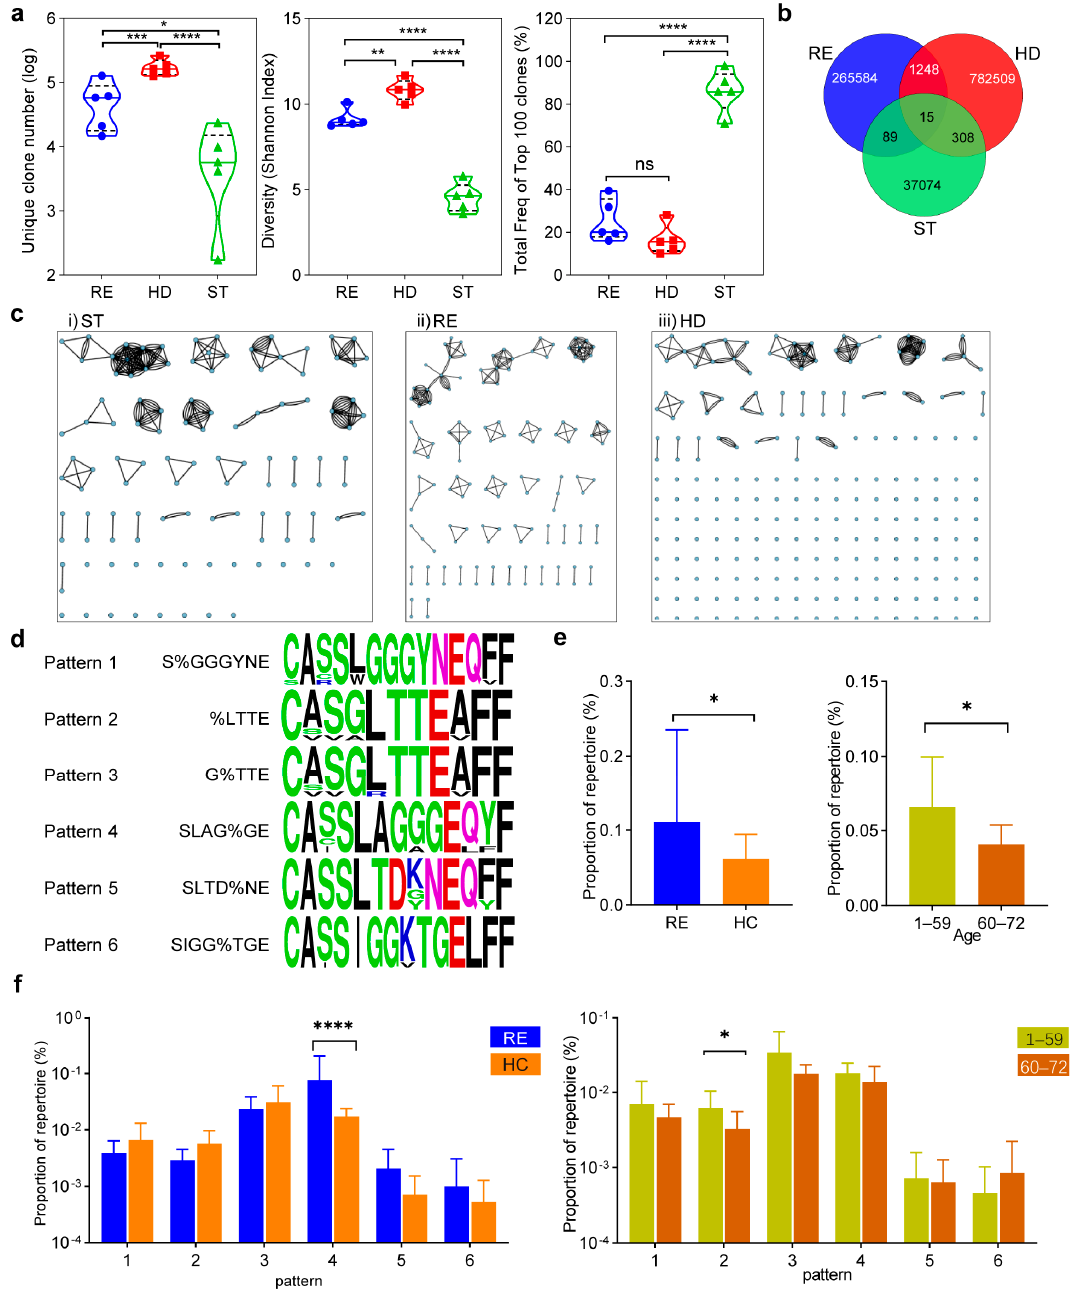
Figure 4. Conserved antigen ‐ specific CD8 + TCR repertoire analysis. The sorted CD8 + T cells (ST), PBMCs of unexposed healthy donors and SARS ‐ CoV ‐ 2 recovered patients (RE) were subjected to TCR β repertoire sequencing. ( a ) Comparison of overall TCR β repertoire diversity and clonality indices among the three groups. The full line is the median and the dotted ‐ line is the quartile. ( b ) Amount of overlap for all unique clones and the public clones among the three groups. ( c ) TCR clones clustering of 3 groups by GLIPH2 algorithm. The dot represents a clone, and two dots are connected if they share a significant motif or have a similar CDR3 region. ( d ) Representative amino acid sequence patterns and logos of 6 prevalent CDR3 clusters in ST group. Clones in the same pattern possess a global similarity with only one amino acid variation in the CDR3 region. ( e , f ) Comparison of proportions of CDR3 cluster patterns between RE group and healthy cohort (HC), and between two age groups in HC. Analysis of the cumulative proportions of the 6 CDR3 cluster patterns ( e ), and the proportions of each CDR3 cluster pattern ( f ). Student’s t test (paired and unpaired) was carried out for two groups statistical analysis, and by ANOVA when more groups were analyzed (* p < 0.05, ** p < 0.005, *** p < 0.001, **** p < 0.0001, ns not